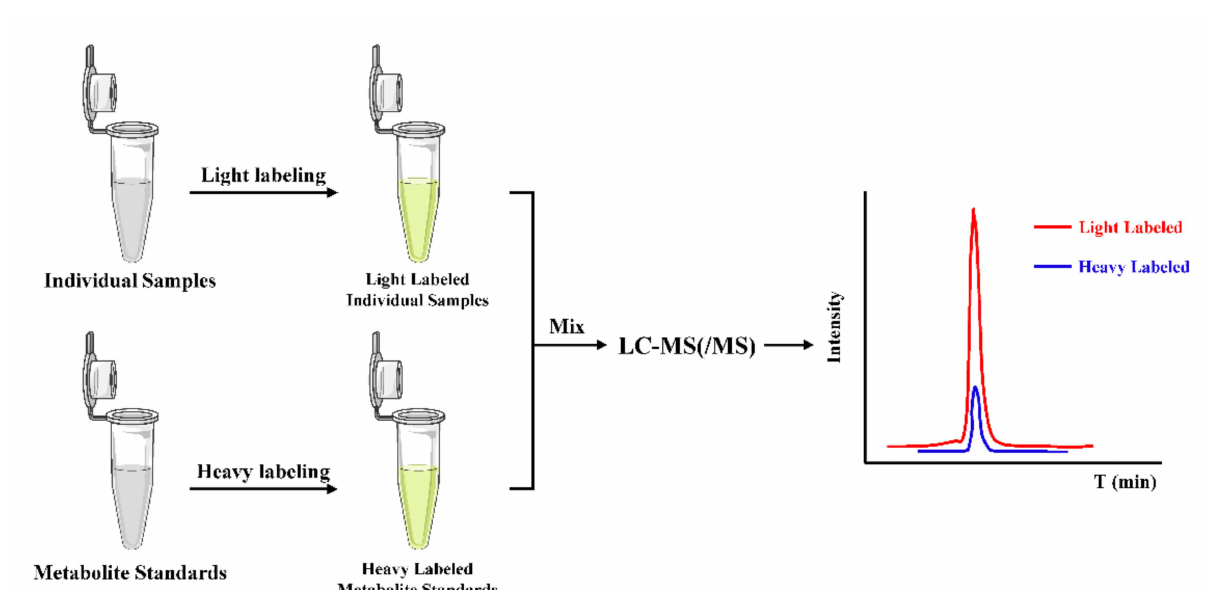
Figure 5. General workflow of the ICD strategy for the absolute